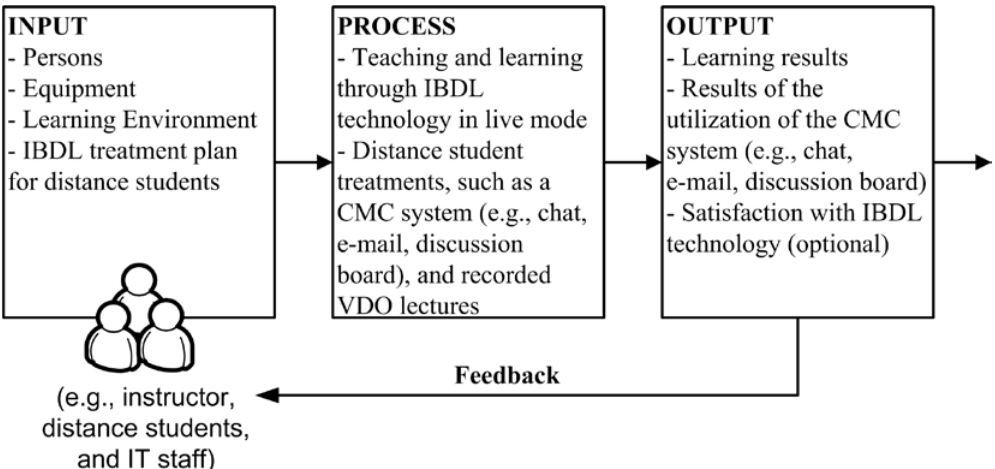
Figure 3. Input, process, and output of the instructional process of IBDL in live mode.